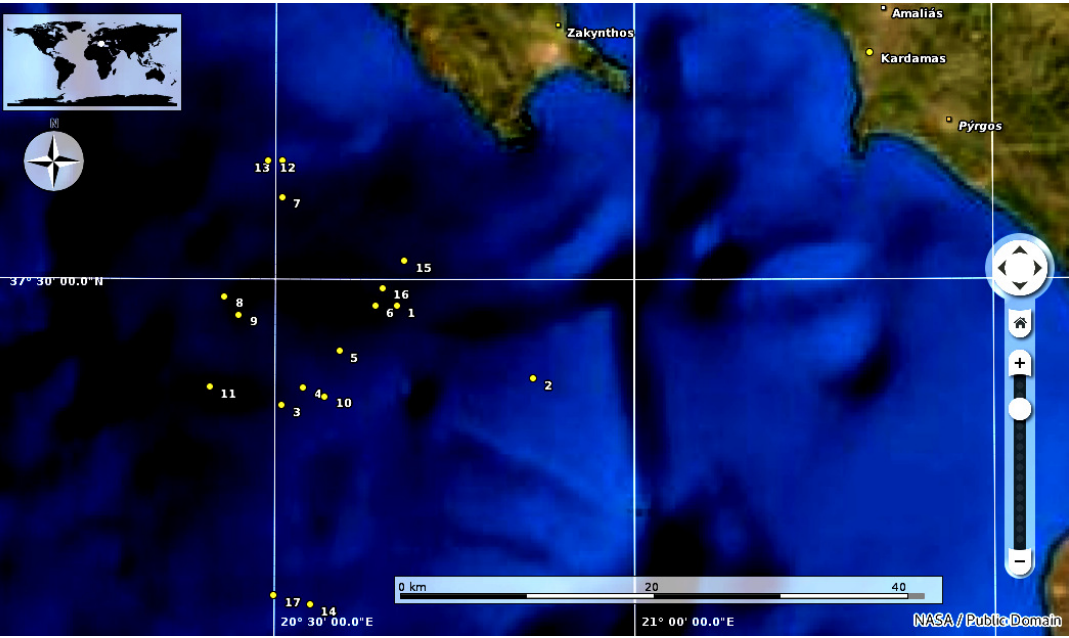
Figure 2. The epicenters of the earthquakes of Table 1 occurred between 2018 / 10 / 26–2018 / 11 / 26 within circle of 101 km radius centered at the Kardamas station (21.34 ◦ E, 37.76 ◦ N). The identifiers are according to Table